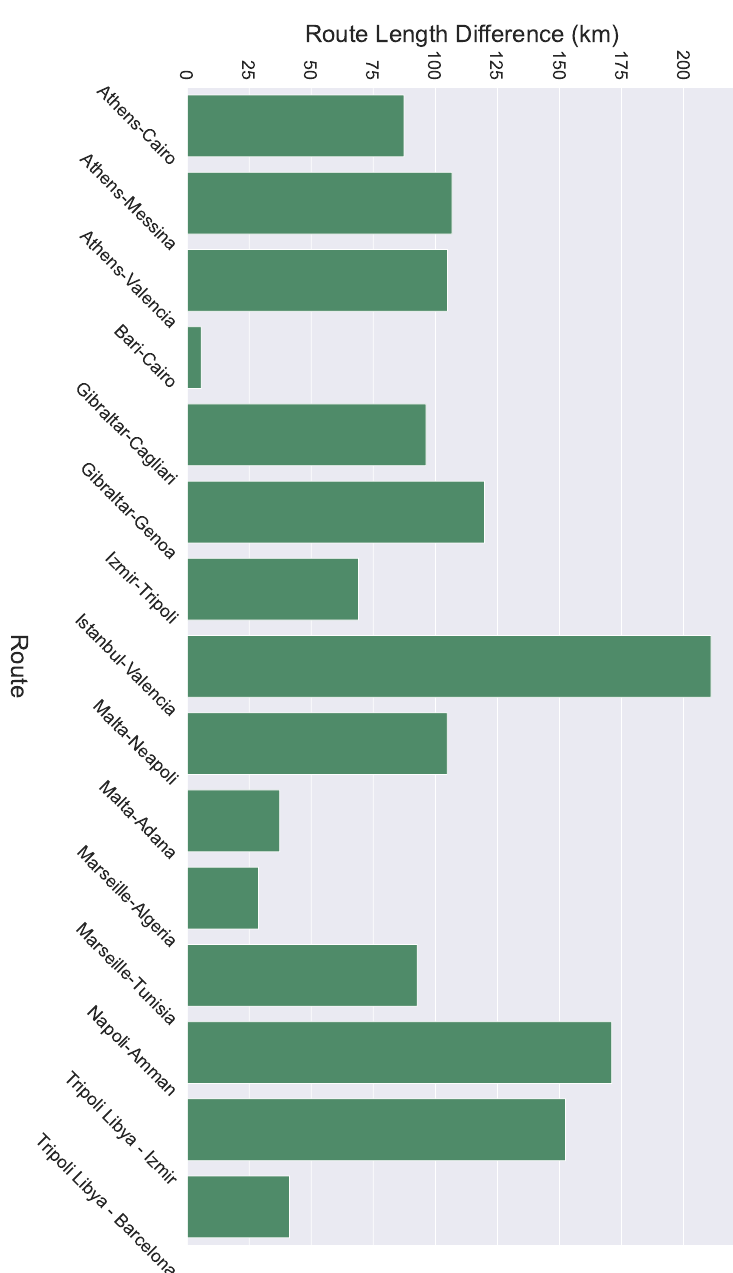
Figure 11. The difference in length between the initial and the recommended